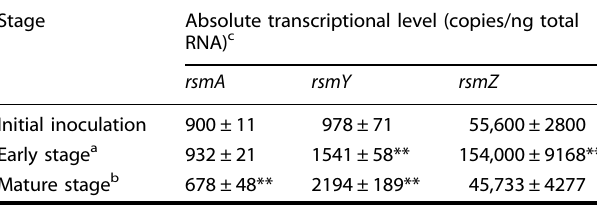
Table 3. Absolute transcription levels of the rsmA, rsmY , and rsmZ genes at different stages of nitrogen- fi xing bio fi lm formation by P. stutzeri A1501.